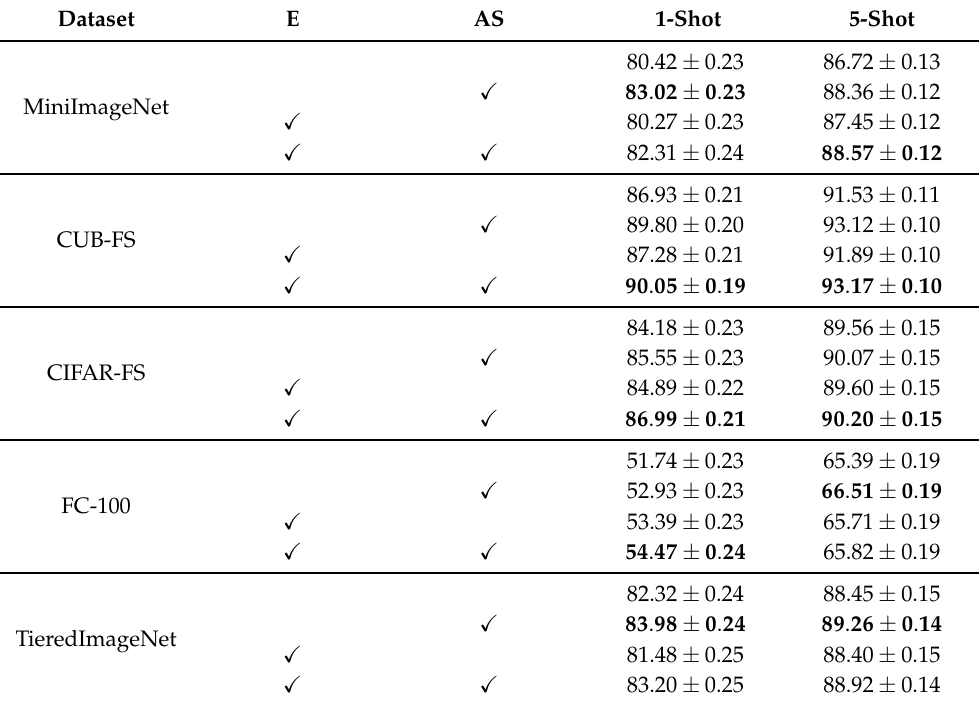
Table 12. Ablation study of the steps of proposed solution in transductive setting for a fixed number of trainable parameters in the considered backbones. When using ensembles, we use (cid:16) (cid:17) 1 √ 2 × ResNet12 instead of a single 2